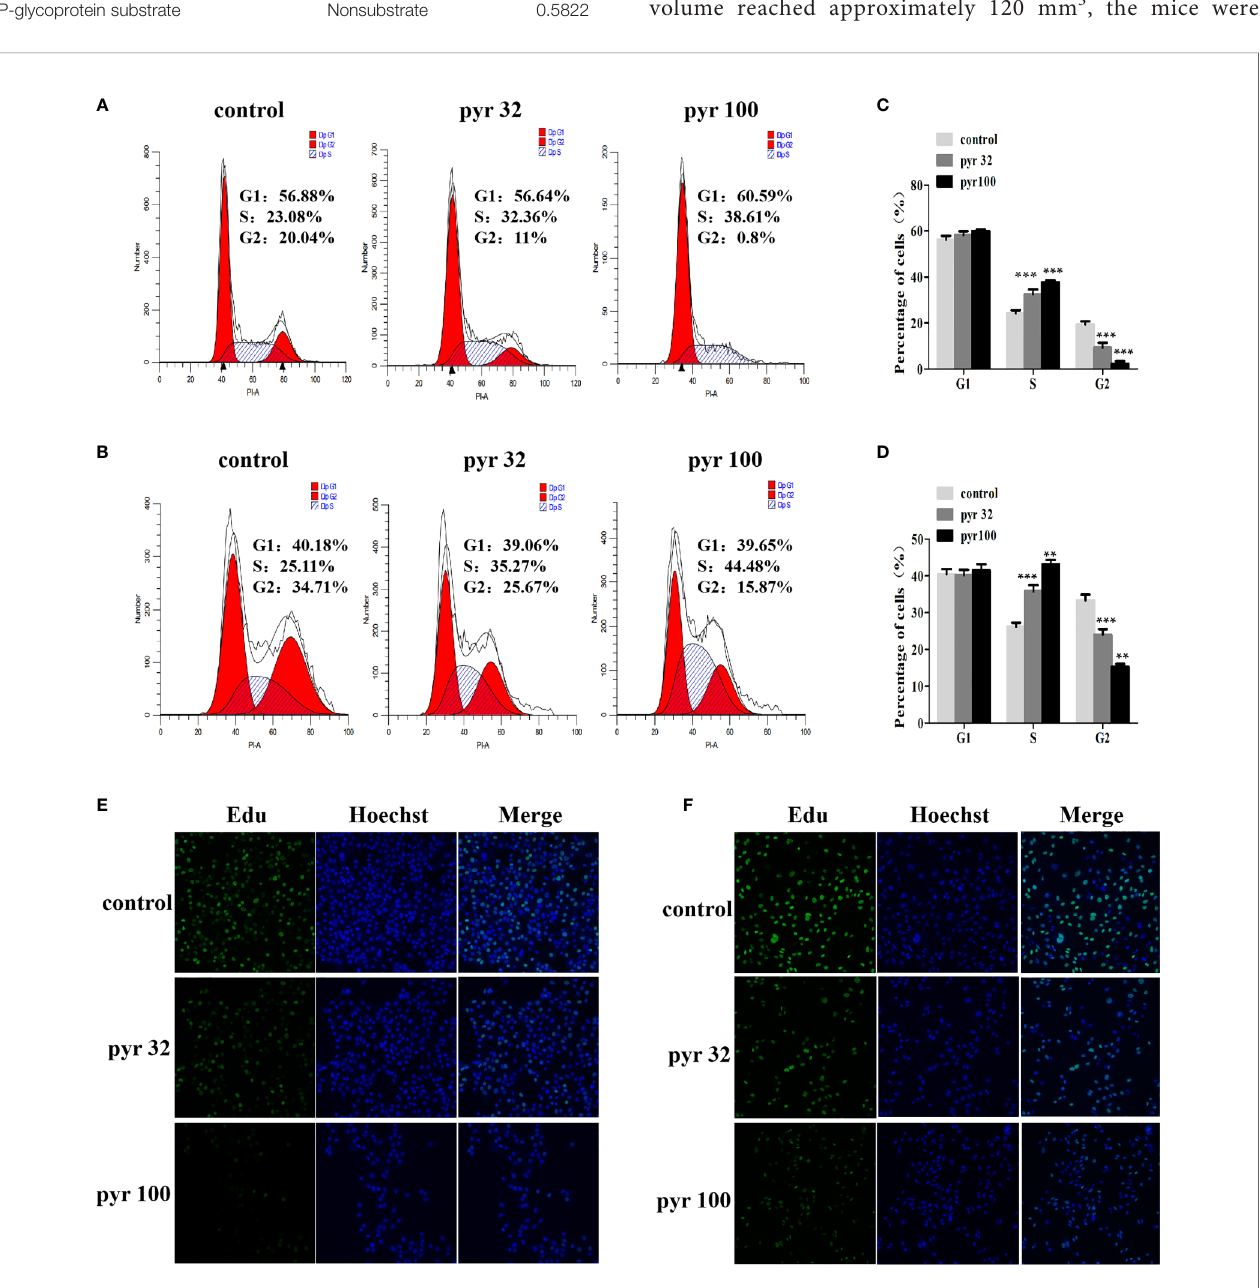
FIGURE 2 | Pyrimethamine arrests the cell cycle at S phase. (A, B) Analyzing the cell cycle arrest after treating with 0, 32, and 100 m M pyrimethamine in DU145 and PC3 cell lines by fl ow cytometry. (C, D) Mean percentage of cells ± SD was shown (DU145 and PC3). ** P < 0.01 ; *** P < 0.001. (E, F) Pyrimethamine represses the DNA synthesis of DU145 (E) and PC3 (F) cells as detected by EdU proliferation